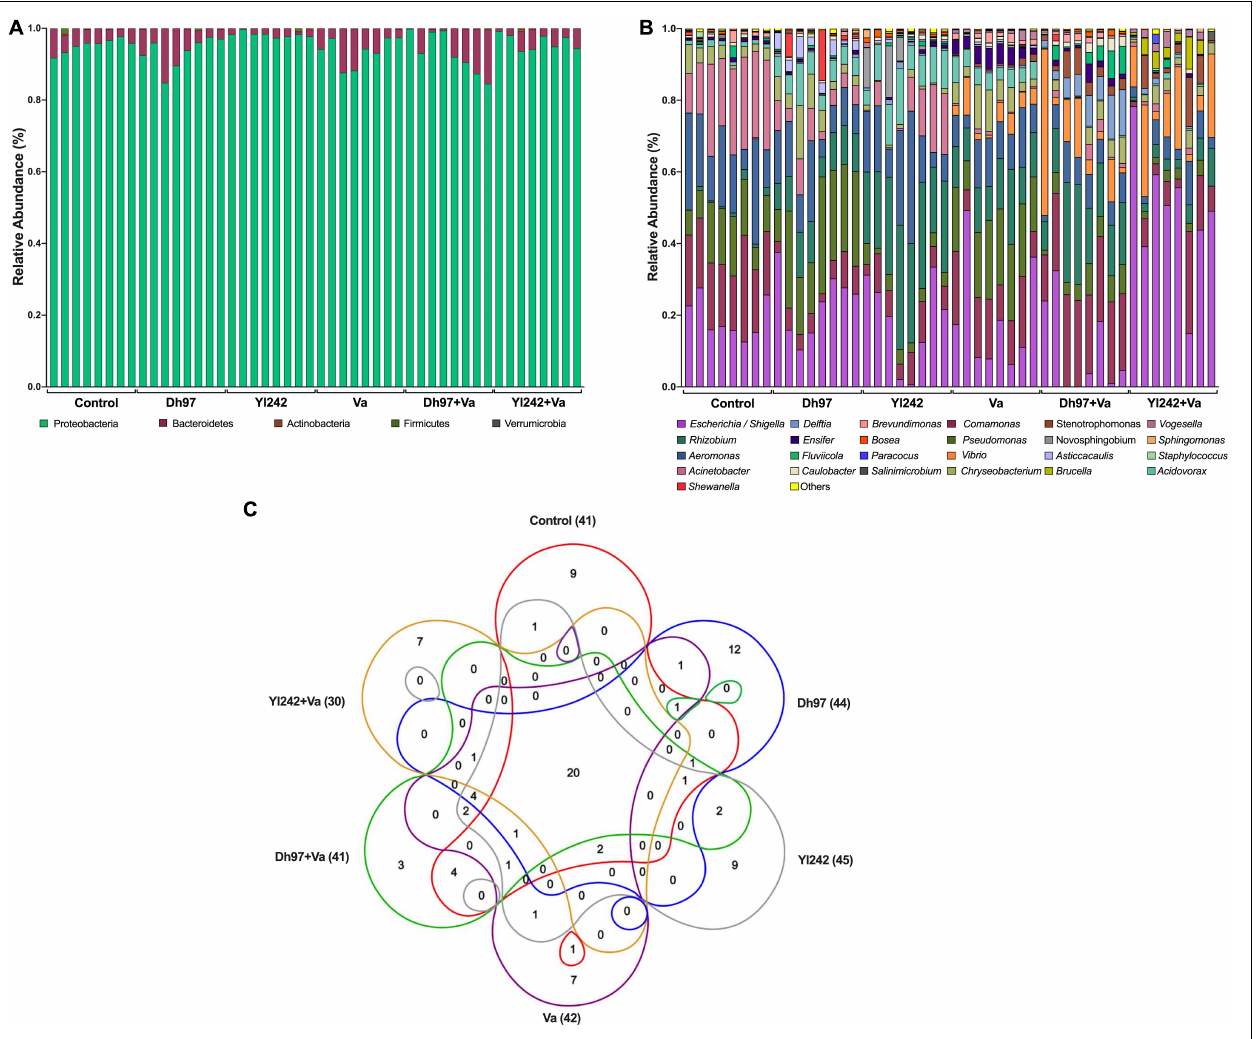
FIGURE 3 | Bacterial composition of Tg(Bacmpx:GFP) i 114 larvae inoculated with yeasts and/or Vibrio anguillarum . (A) Phylum level, (B) genus level, and (C) venn diagram showing the number of shared and unique genera among groups. Analysis of the bacterial microbiota was performed in Tg(Bacmpx:GFP) i 114 zebrafish larvae at 8 days post fertilization (dpf), corresponding to 3 days post V. anguillarum infection. Control group: non-inoculated conventionally raised larvae (CONV-R). Dh97 and Yl242 groups: CONV-R larvae inoculated by immersion with 5 × 10 6 CFU/mL of D. hansenii 97 or Y. lipolytica 242, respectively, at 4 dpf. Va group: CONV-R larvae challenged at 5 dpf by immersion with 10 7 CFU/mL of V. anguillarum . Dh97 + Va and Yl242 + Va groups: CONV-R larvae inoculated by immersion with both yeasts at 4 dpf and challenged with V. anguillarum at 5